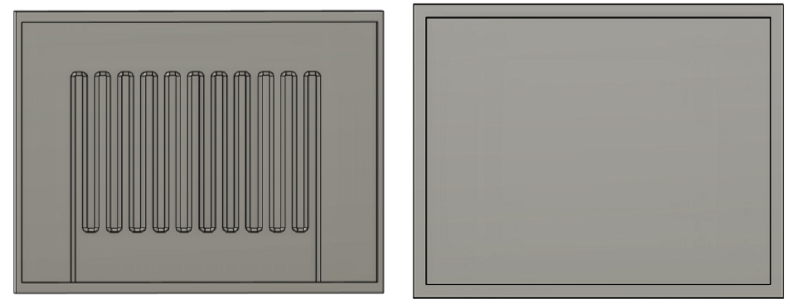
Figure 4. The bottom lid of the sensor (pre-mold processing) and top lid for the fabrication of the soft